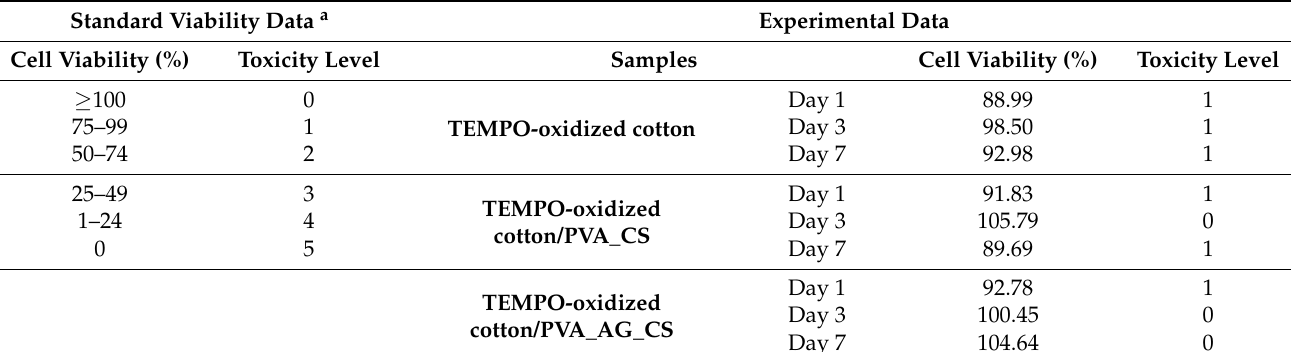
Figure 7. Evaluation of the normal human dermal fibroblast (NHDF) cell viability after 1, 3, and 7 days in contact with the TEMPO-oxidized cotton and the produced dual-layer dressing materials. Moreover, the toxicity levels of the produced dual-layer dressing materials were determined from the standard percentage cell viability ranges (as seen in Table 2). The obtained results showed that the tested materials displayed toxicity levels between 0 and 1, which are considered as nontoxic to the human body [39]. Table 2. Classification of the toxicity level of the produced dual-layer dressing materials depending on the percentage of cell viability